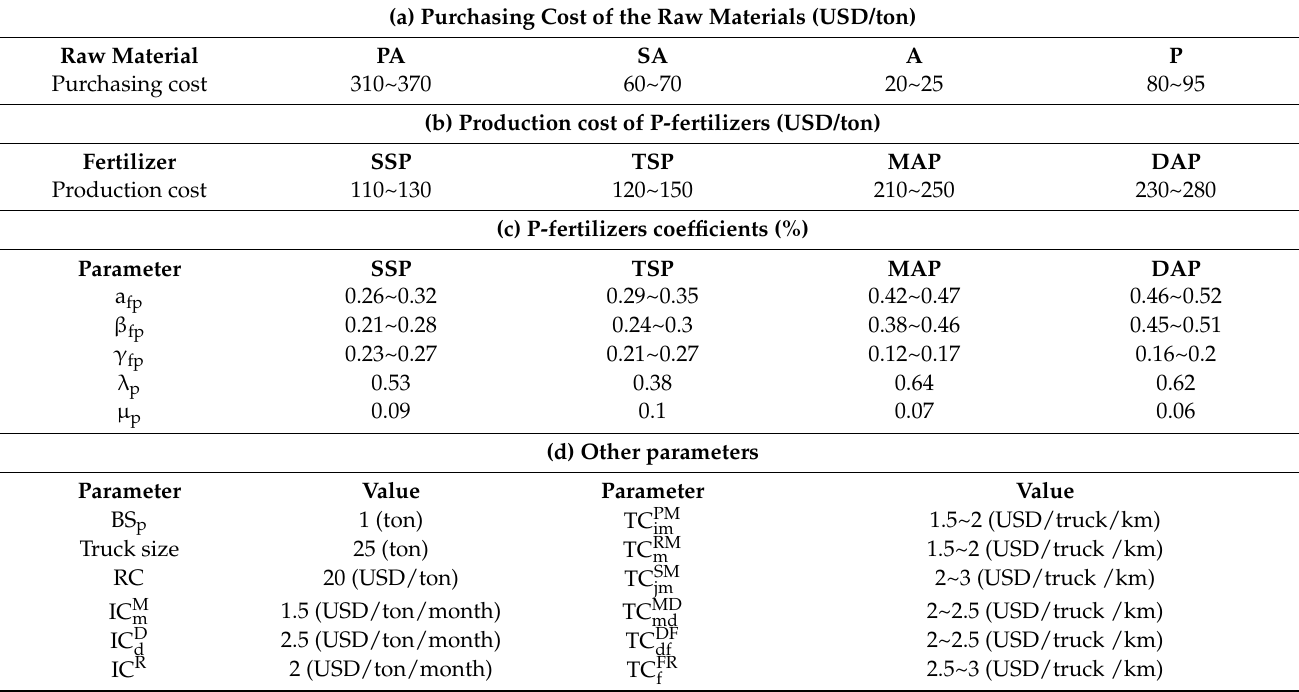
Table 7. Setting of the PFSCM model